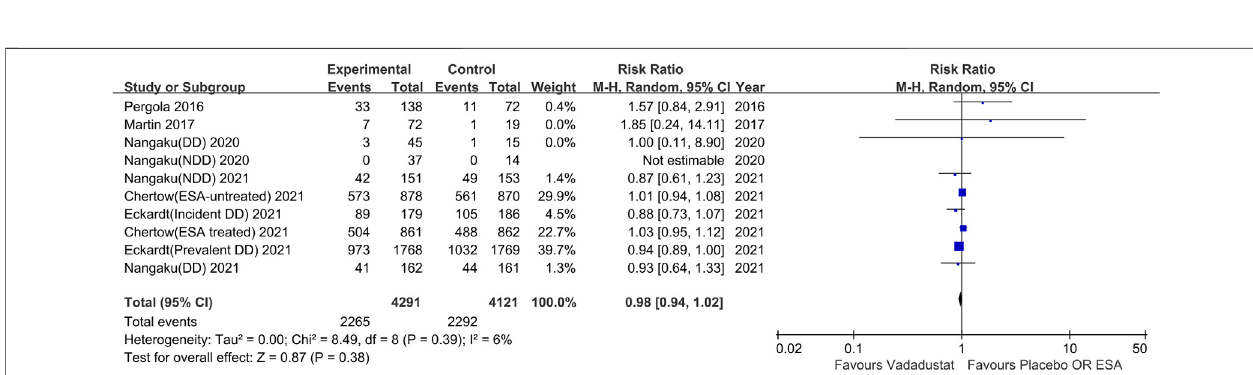
FIGURE 4 | Any adverseevents with vadadustatversus placebo or darbepoetin alfa. EAS, erythropoiesis-stimulating agent, only darbepoetin alfa. The registration number of Nangaku (NDD) 2020 corresponds to NCT03054337, Nangaku (DD) 2020 corresponds to NCT03054350, Chertow (ESA-untreated) 2021 corresponds to NCT02648347, Chertow (ESA treated) 2021 corresponds to NCT02680574, Eckardt (incident DD) 2021 corresponds to NCT02865850, Eckardt (prevalent DD) 2021 corresponds to NCT02892149, Nangaku (NDD) 2021 corresponds to NCT03329196, Nangaku (DD) 2021 corresponds to NCT03439137.